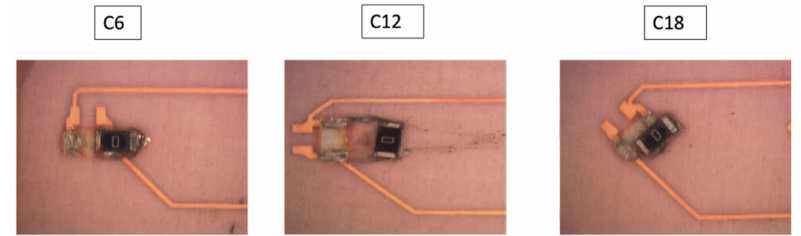
Figure 39. Out-of-place components.